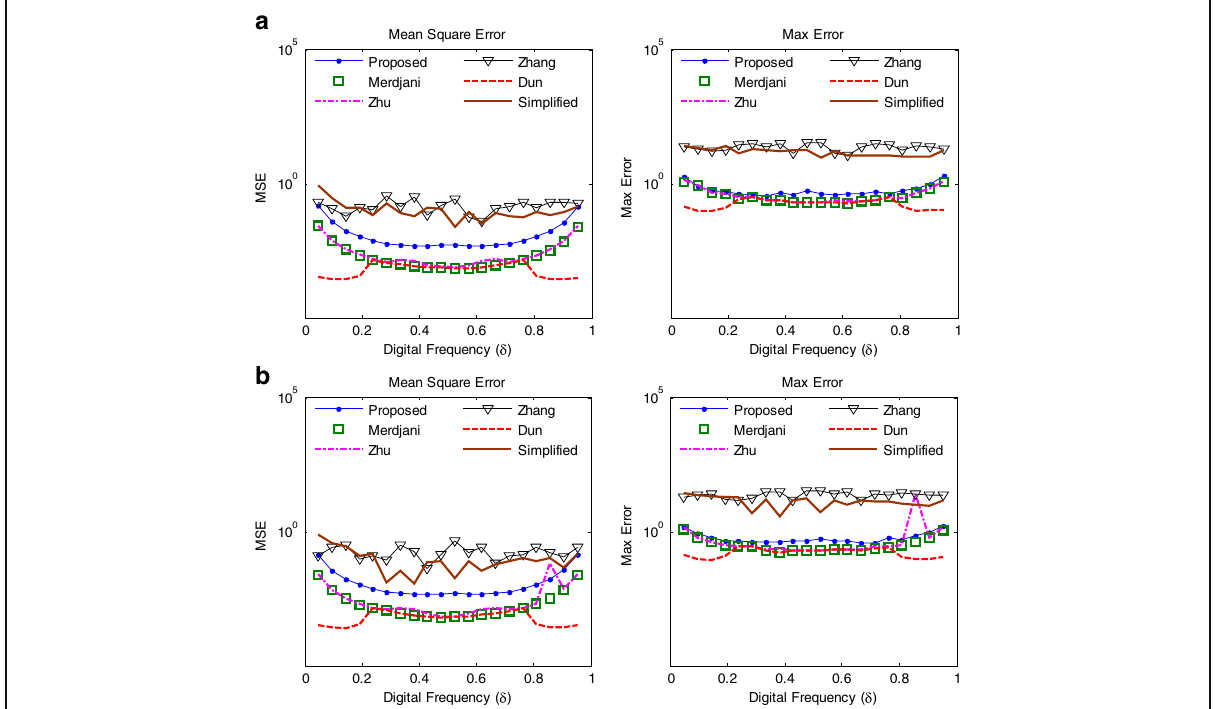
Fig. 2 MSE comparison of the estimators for single-tone sinusoidal input polluted by noise. Two sets of the sinusoidal signal were used. The results of the two sets are presented in ( a ) and ( b ). We set l 0 =46 for ( a ) and l 0 =510 for ( b ). SNR=40 dB. There were averages of 10,000 runs for each frequency